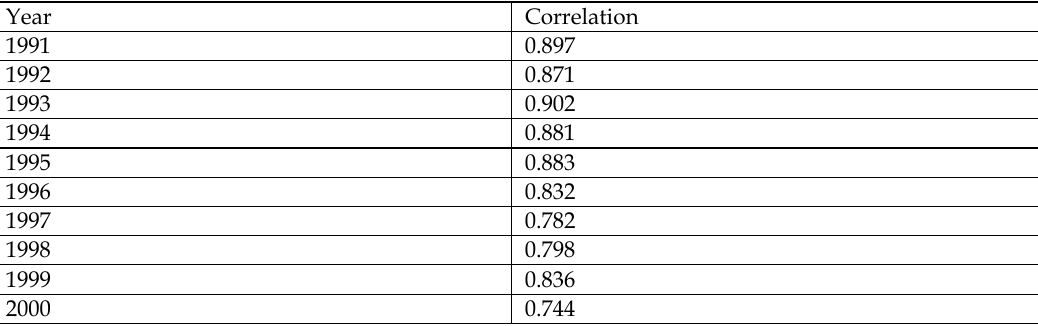
Table 4. TE Estimates’ Correlation by